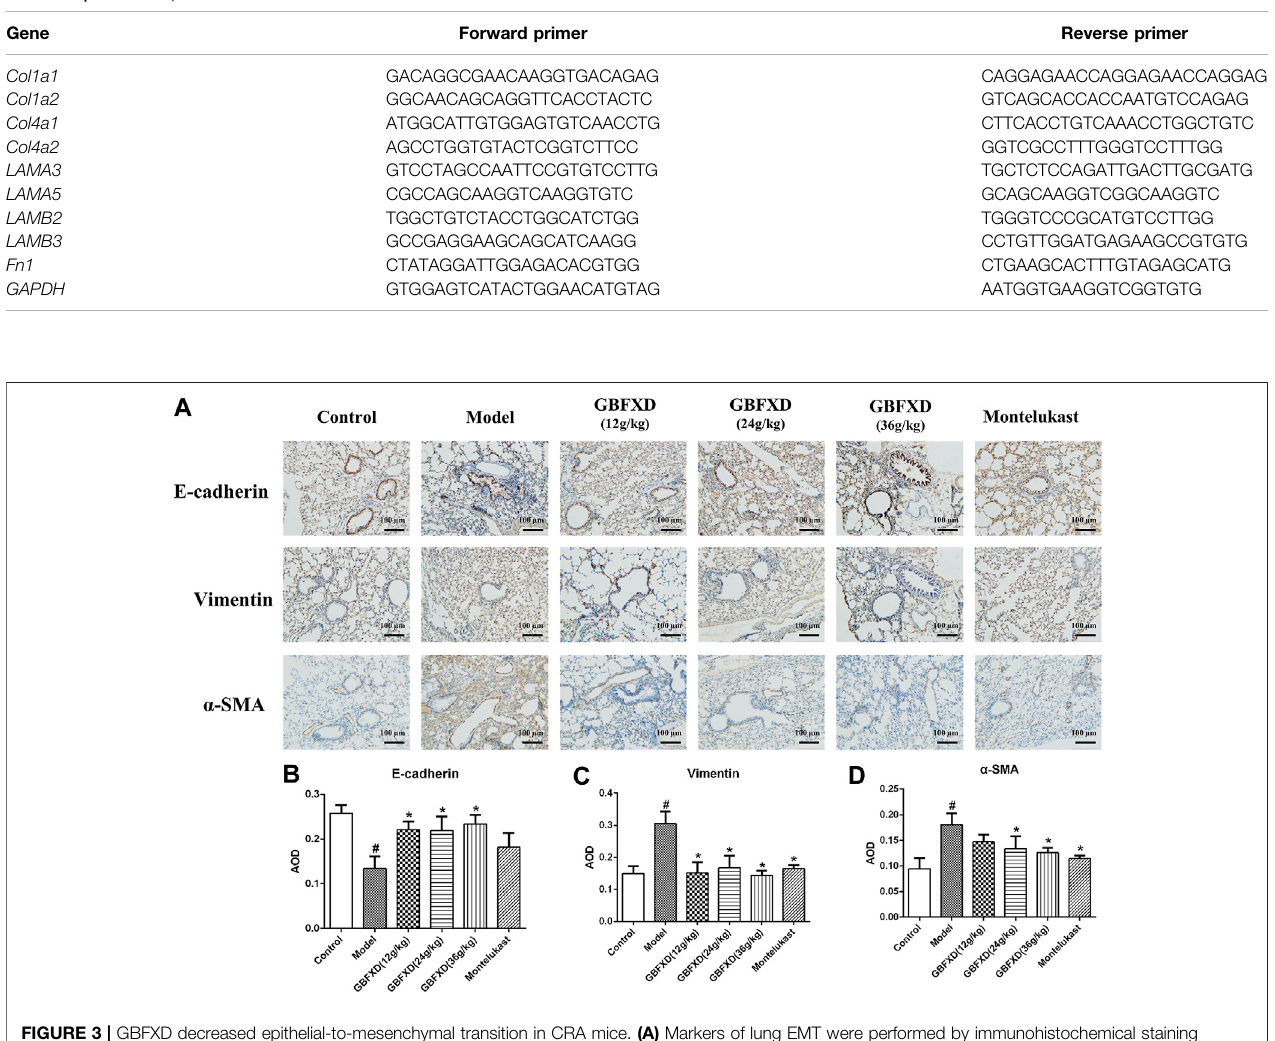
FIGURE 3 | GBFXD decreased epithelial-to-mesenchymal transition in CRA mice. (A) Markers of lung EMT were performed by immunohistochemical staining ( × 200), Scale bar: 100 μ m. (B – D) Relative protein expressions of E-cadherin (epithelial mark), Vimentin and α -SMA (mesenchymal marks) were quanti fi ed by AOD. Values are presented as mean ± SD ( n (cid:2) 3 mice per group). # p < 0.05 compared to control group, and * p < 0.05 compared to model